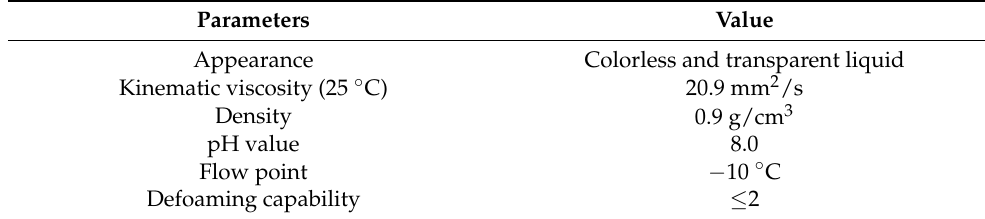
Table 2. Physicochemical properties of the base